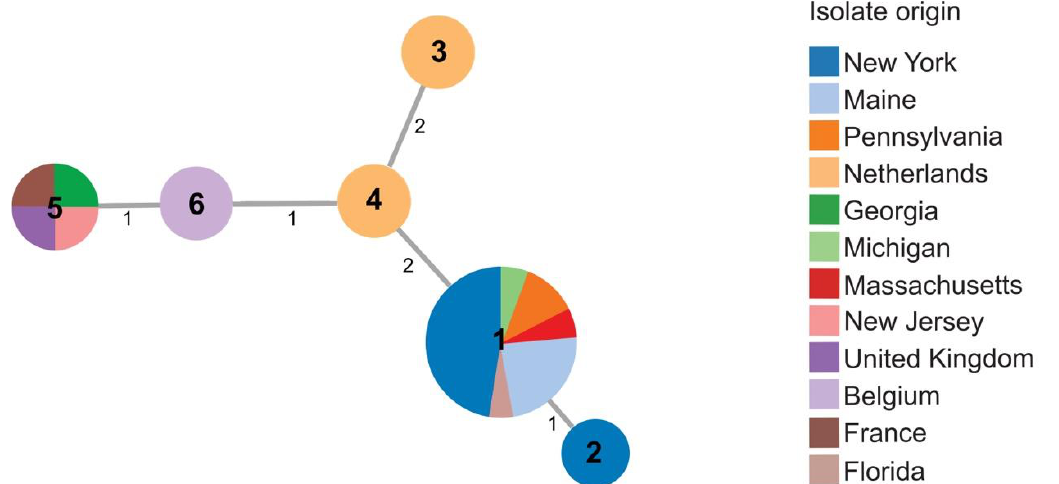
Figure 3. Minimal spanning tree showing relatedness of 25 strains of D. dianthicola including 19 strains obtained in 2015– 2016. Each circle represents a unique sequence type (ST) derived from the concatenated sequences of three housekeeping genes ( dnaJ , dnaX , and gyrB ). Sequence type numbers are given in black in each circle. Sizes of circles are relative to the number of individuals sharing the same ST. The relatedness between strains is indicated by relative distance as indicated by branch lengths. Geographic origins of strains are depicted by color: New York (blue); Maine (light blue); Pennsylvania (orange); Netherlands (light orange); Georgia (green); Michigan (light green); Massachusetts (red); New Jersey (pink); United Kingdom (purple); Belgium (light purple); France (brown); Florida (light brown).